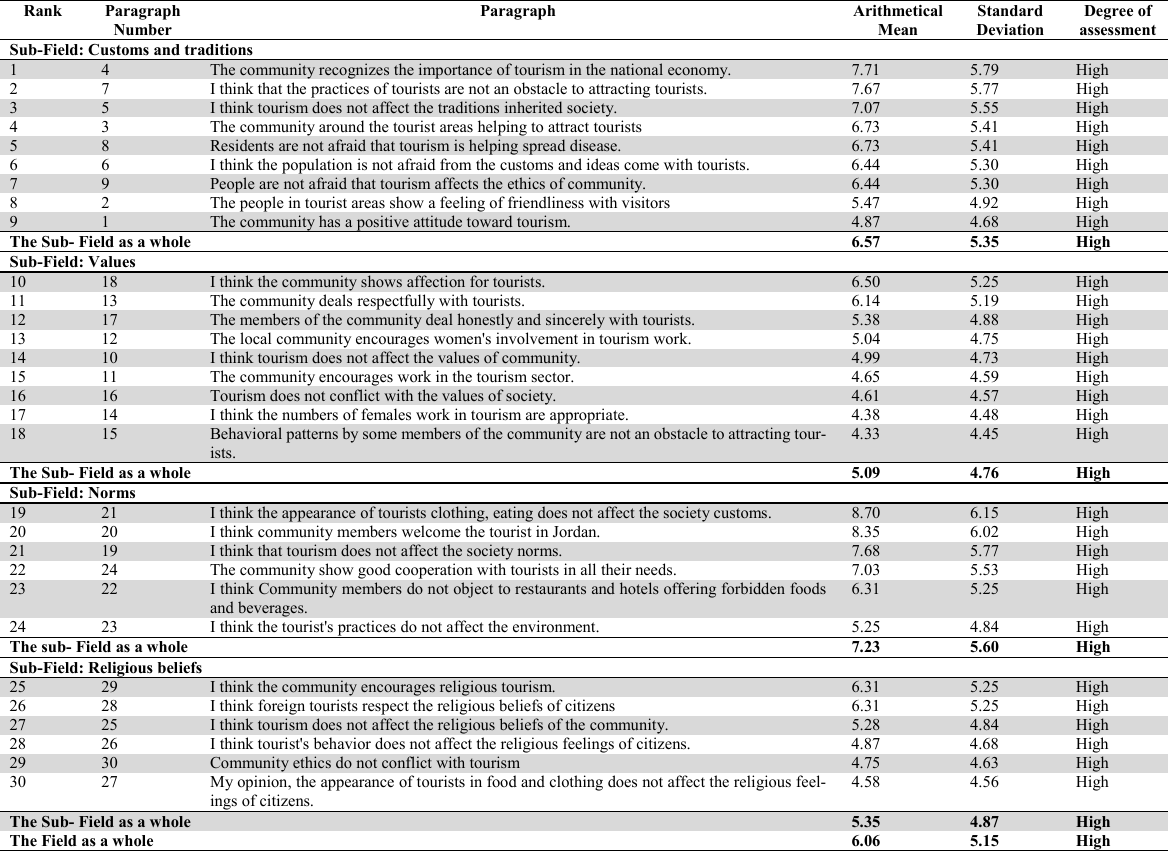
Table 1 The summary of means and standard deviations of elements of cultural dimensions Rank